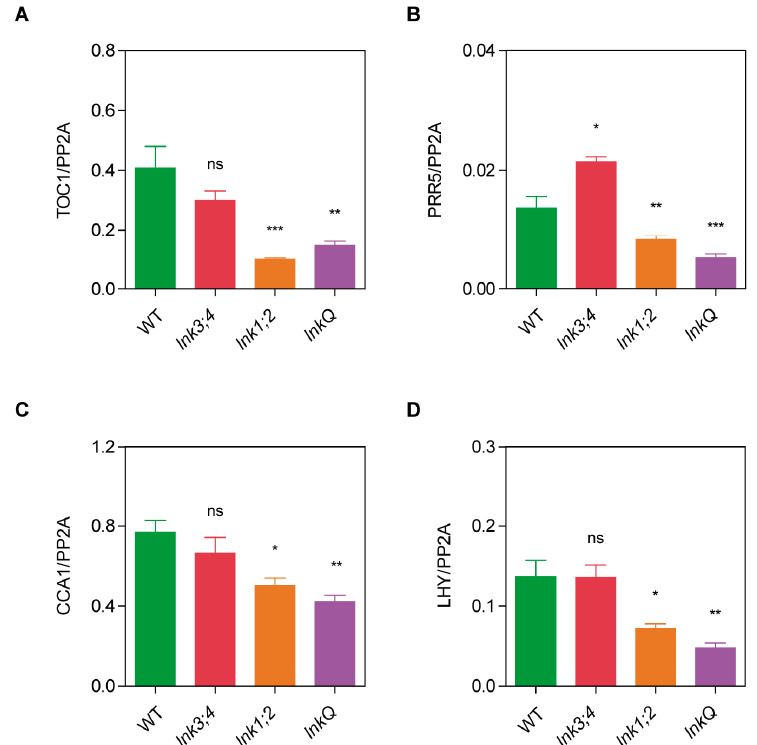
Figure 4. LNK family members regulate the expression of central morning and evening clock genes. Mean expression levels were measured using quantitative PCR (qPCR) for the evening genes ( a ) TOC1 and ( b ) PRR5 , as well as for the morning genes ( c ) CCA1 and ( d ) LHY . Four biological replicates were used for measuring mRNA abundance. The analysis was conducted after pooling samples collected every 4-h across a time-course series, in order to evaluate difference in absolute mRNA levels among genotypes, rather than differences resulting from alterations in the timing of gene expression. Error bars indicate SEM. Student’s t -test was performed between mutants and WT (*: significantly different, p ≤ 0.05; **: significantly different, p ≤ 0.01; ***: significantly different, p ≤ 0.001; ns: not